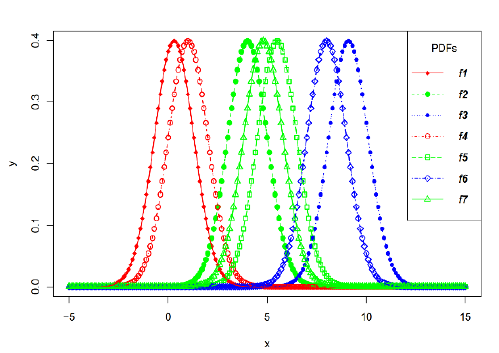
Fig. 3: The clustering result of seven PDFs in example 1 by non-hierarchical algorithm in R.